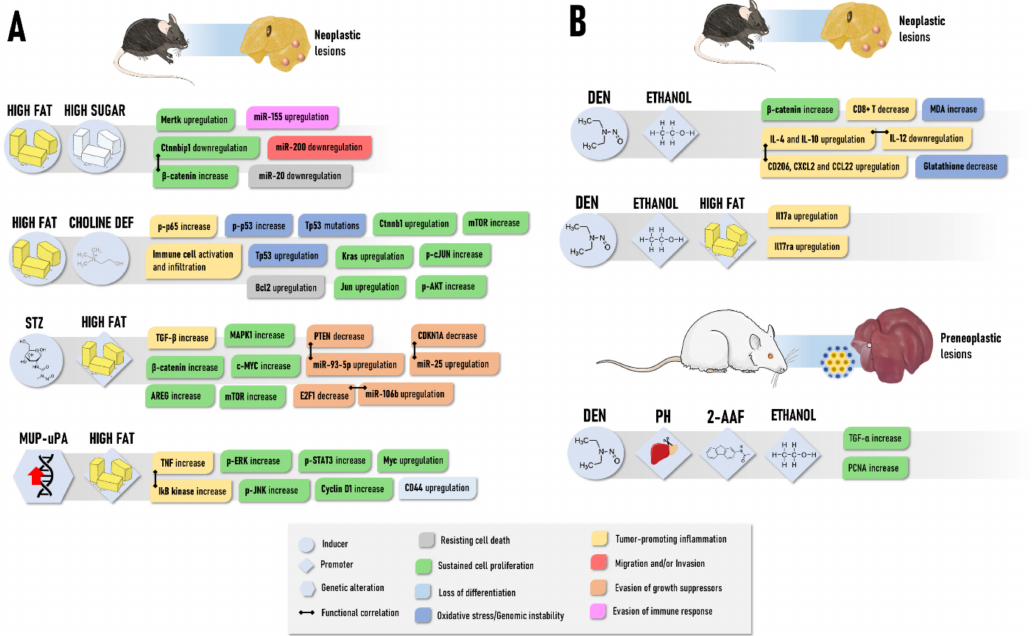
Figure 4. General depiction of the main molecular alterations and functional hallmarks involved in the development of neoplastic (adenomas and carcinomas) lesions in NASH-driven ( A ) or ALD-driven models ( B ) in mice and rats. NASH: Non-alcoholic steatohepatitis; ALD: Alcoholic liver disease. The figure was composed with the aid of illustrations from the SMART-servier Medical Art available at https://smart.servier.com/ (accessd on 15 January